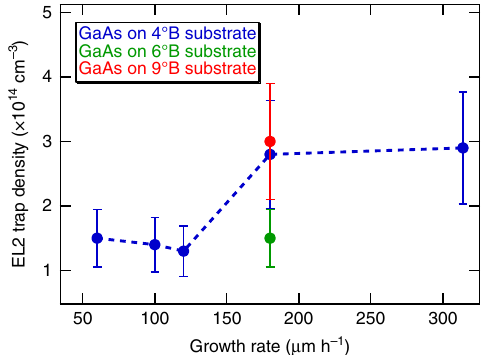
Fig. 5 EL2 trap density as a function of growth rate for GaAs solar cells grown by D-HVPE. The error bars are standard deviations of trap density measured from the same sample multiple